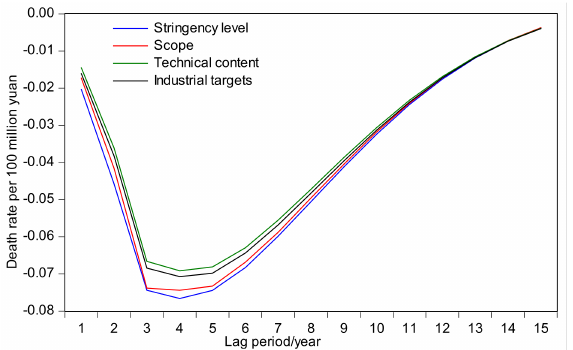
Figure 6. Impulse response function of safety policy indexes to the death rate (no standard